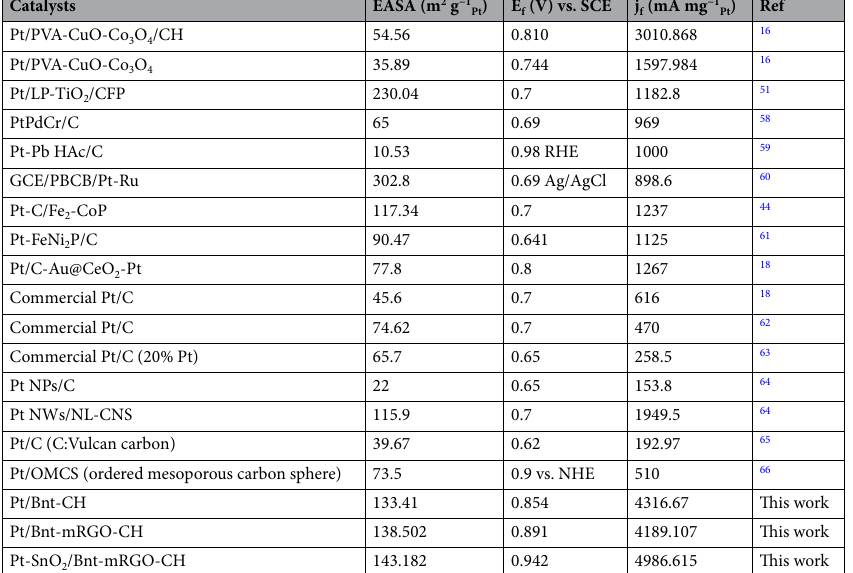
Table 1. Electrochemical data of methanol electro-oxidation at various catalysts.